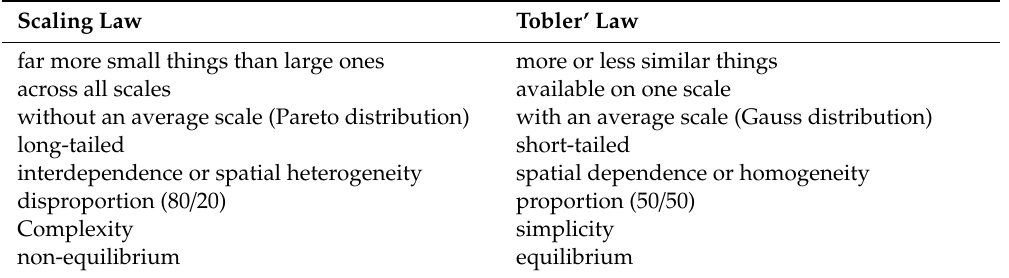
Table 2. Scaling law and Tobler’s law of living structure. Note: These two laws are complementary of—rather than contradictory to—each other and they recur at di ff erent levels of scale of living